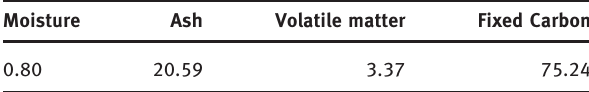
Table 3: Industrial analysis of coke